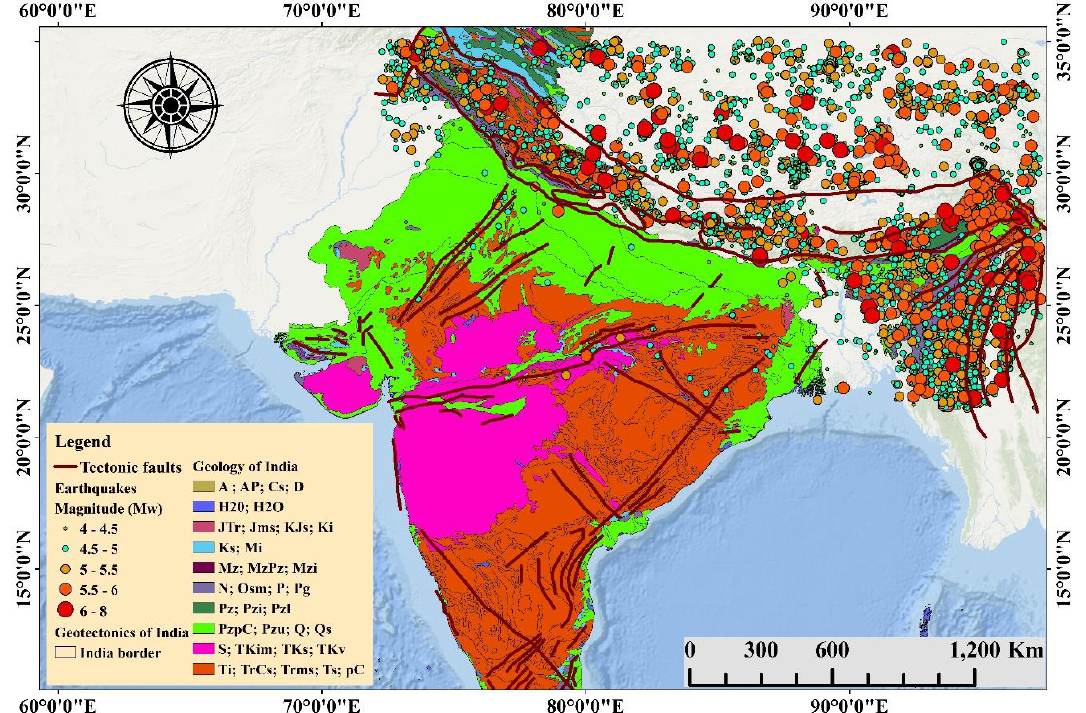
Figure 2. Location of the study area showing the tectonics and detailed geology of the Indian subcontinent with earthquake events of Mw > 4 in the Himalayan region (events and faults information were collected from articles [27–29]). (A: Archean, Ap: Archean and Proterozoic, Cmsm: